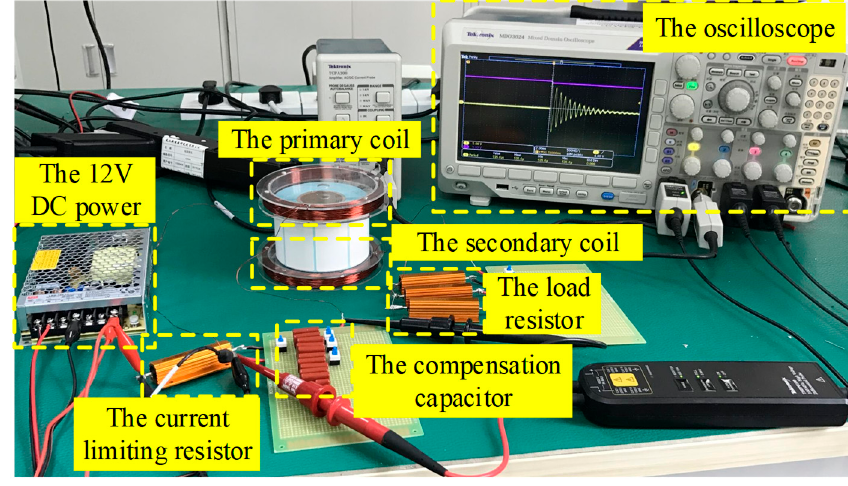
Figure 7. The passive wireless measurement system.